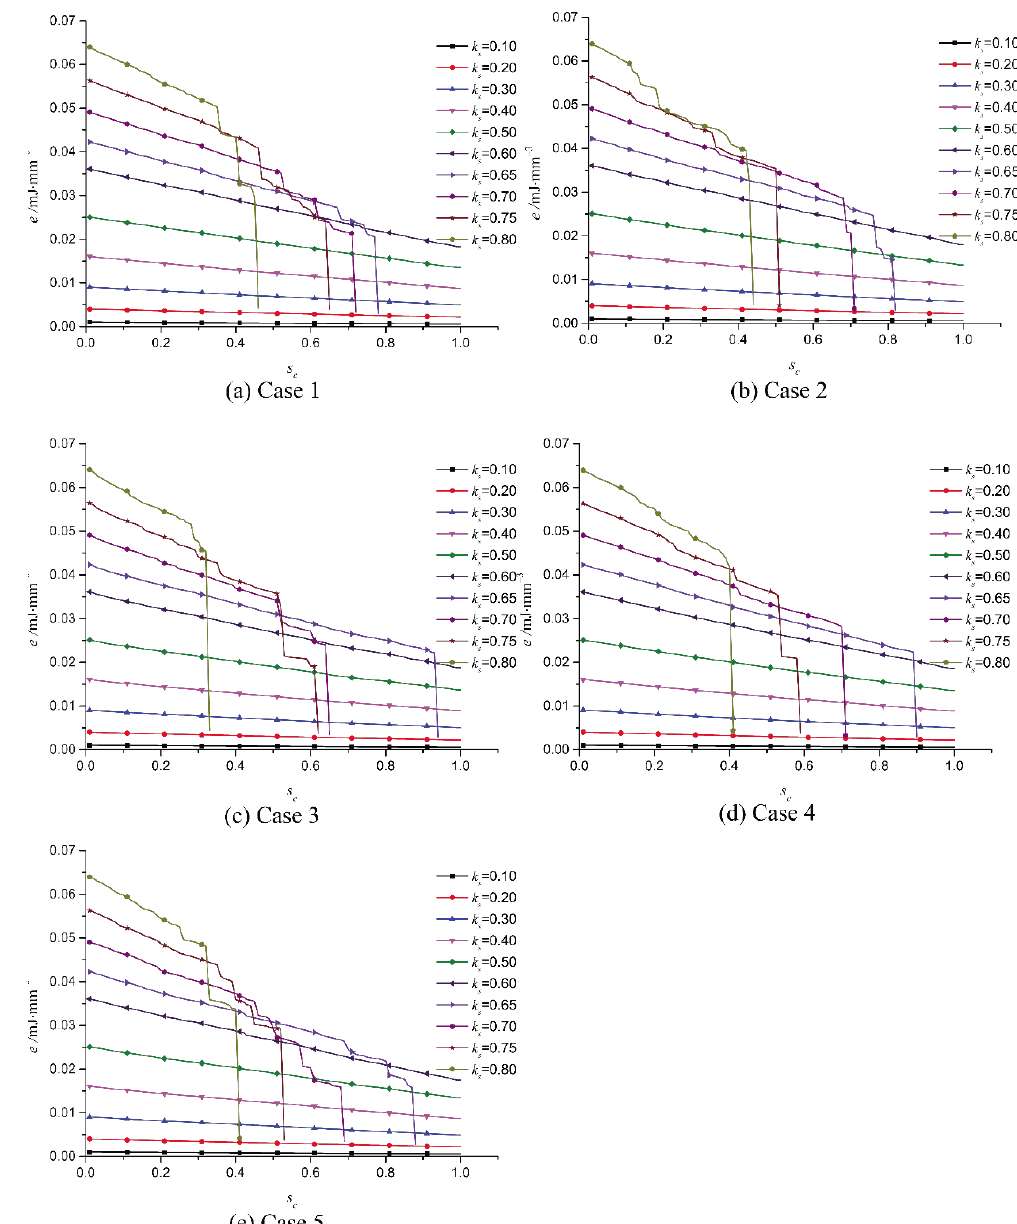
Figure 10. Strain energy evolution versus k s in different cases.